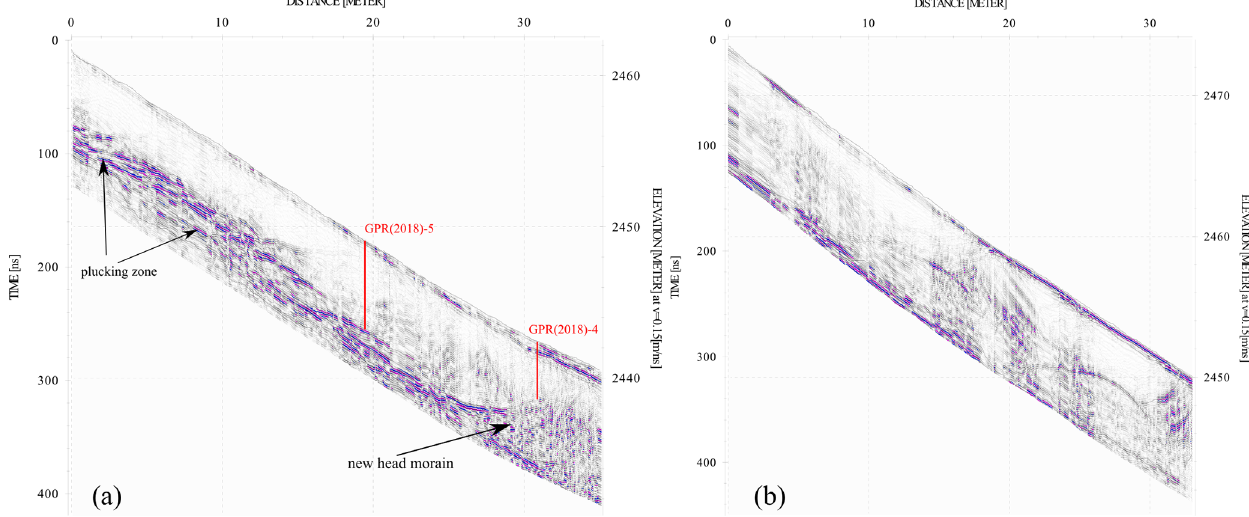
Figure 5. GPR profiles from 2020 along the slope of Snezhnika: (a) GPR(2020)-1 north; (b) GPR(2020)-2 south. Red lines indicate the point of intersection of GPR(2020)-1 with GPR(2018)-4 and GPR(2018)-5.